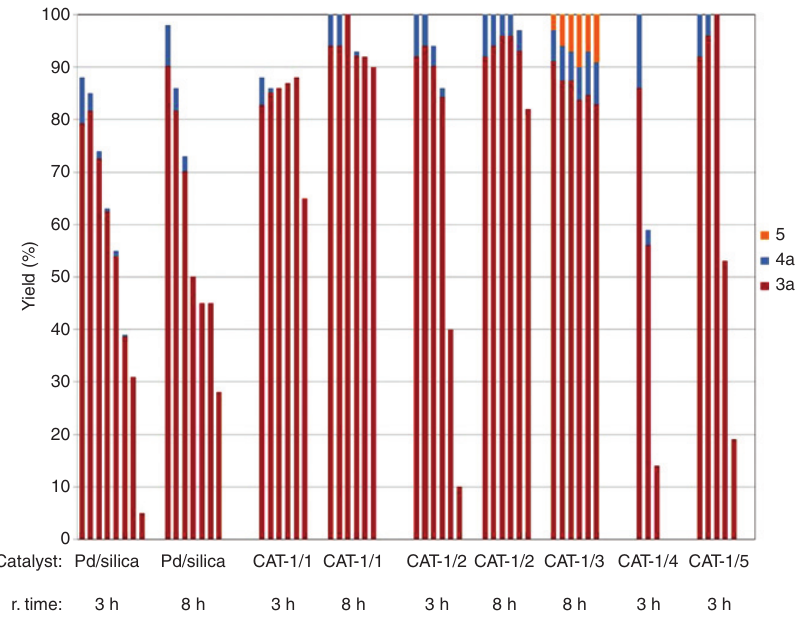
Figure 2: Selectivity and recyclability of catalysts immobilised on silica or SILP-1 in aminocarbonylation carried out in DMF [0.2 mmol 1 , 0.5 mmol 2a , 0.25 mmol Et N, catalyst (with 3.6 μ mol Pd-content), 1 ml DMF, 30 bar CO, 100 ° 3